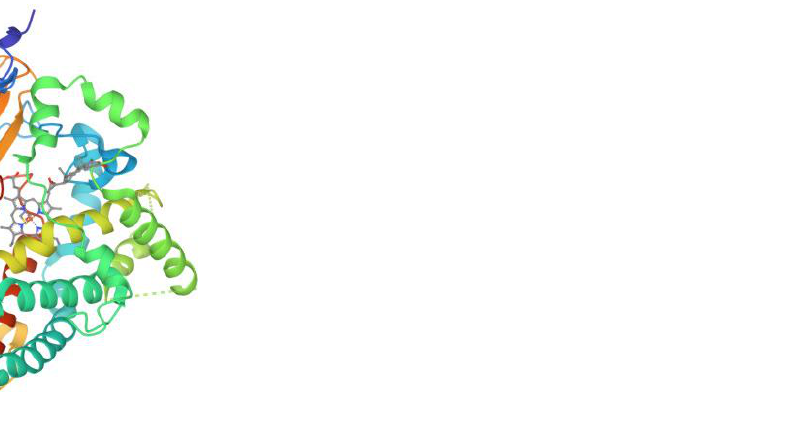
Figure 1. Crystal structure of human CYP3A4 (image from the RCSB PDB (rcsb.org) of 1W0F) [40].